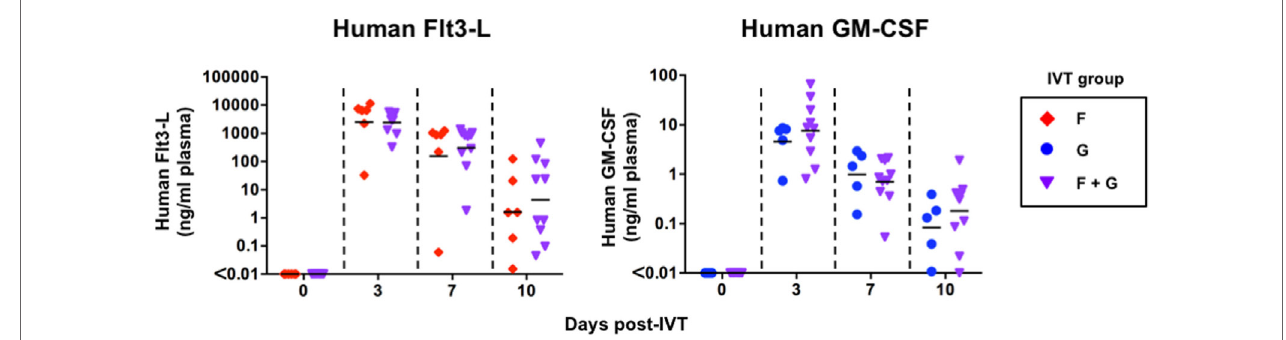
FigUre 1 | Induction of human fms-related tyrosine kinase 3 ligand (Flt3-L) and granulocyte-macrophage colony-stimulating factor (GM-CSF) in hNOJ mice following in vivo transfection (IVT). Humanized NOJ mice were injected with plasmids expressing human Flt3-L (Group F), GM-CSF (Group G), or both (Group F + G). Plasma samples obtained at the indicated time points were subjected to cytometric bead array. Data are the individual values and the geometric mean for each group (Group F: n = 6, Group G: n = 5, Group F + G: n = 10). The Mann–Whitney U test was used to compare IVT groups, and no significant differences were observed at any time point ( P >